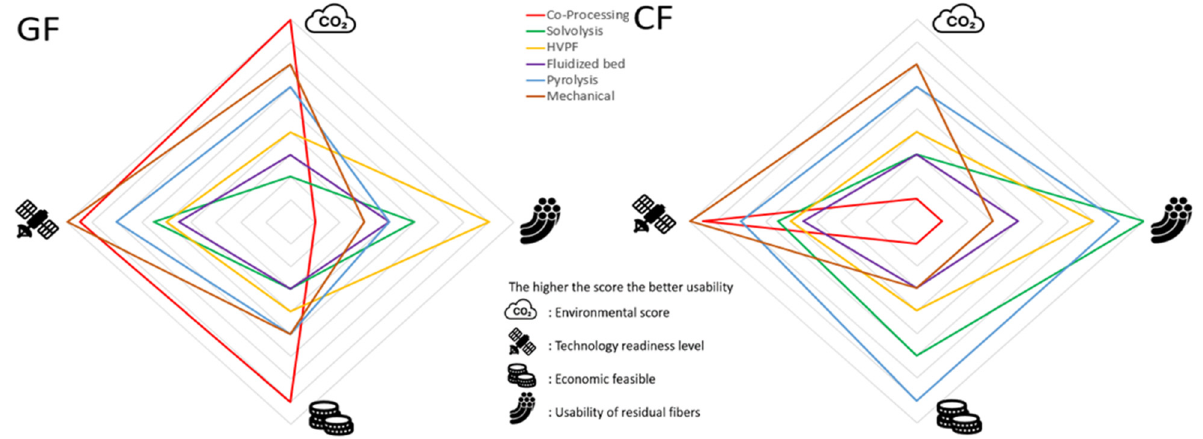
Figure 6. Spider web comparison of the possible recycling methods.